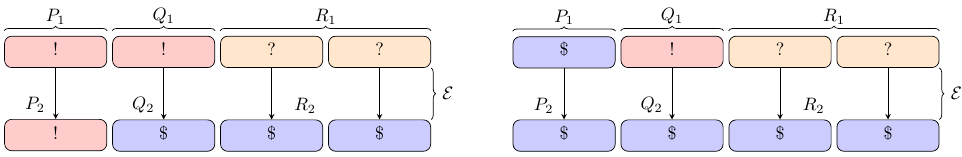
Figure 6: Intuition behind Lemma 5 (left) and Lemma 6 (right). In either case, P is a string of p blocks, Q is one block long, with R of variable length. Blocks marked ? have unknown (and irrelevant) distributions, $ blocks are uniformly sampled, and ! blocks take a unique value on each query (in some sense). The first diagram represents that the block Q 2 , and all subsequent blocks R 2 , are uniformly sampled until ( P 1 , Q 1 ) repeats or the combination ( P 1 , Q 2 ) collides. The second extends this, since if P 2 is uniformly sampled then the whole output is uniformly sampled, subject to the same repeat/collision events.